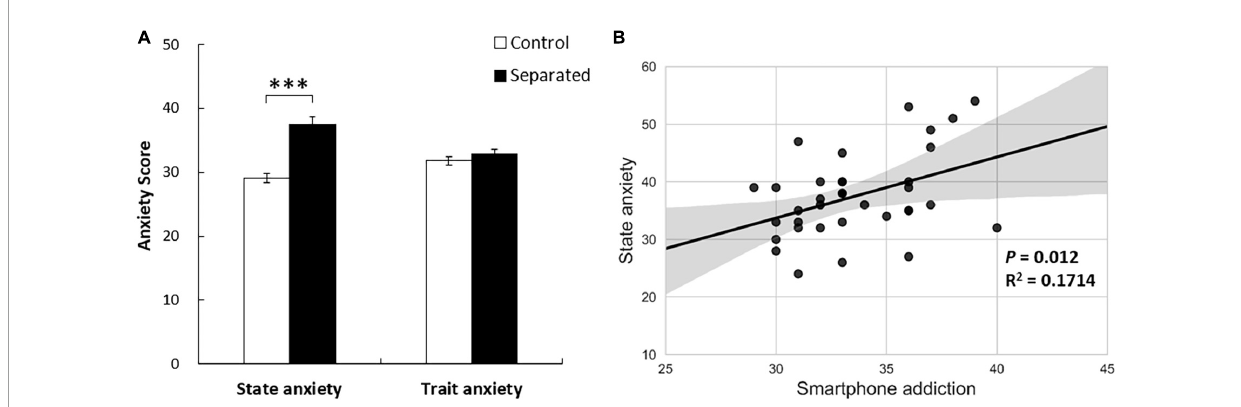
FIGURE2 (A) A significant difference was observed regarding the effect of state anxiety, but no significant difference was observed with respect to trait anxiety. Error bars denote the standard error of the mean. (B) Smartphone addiction was positively correlated with state anxiety in the smartphone separation condition. ∗∗∗ p <